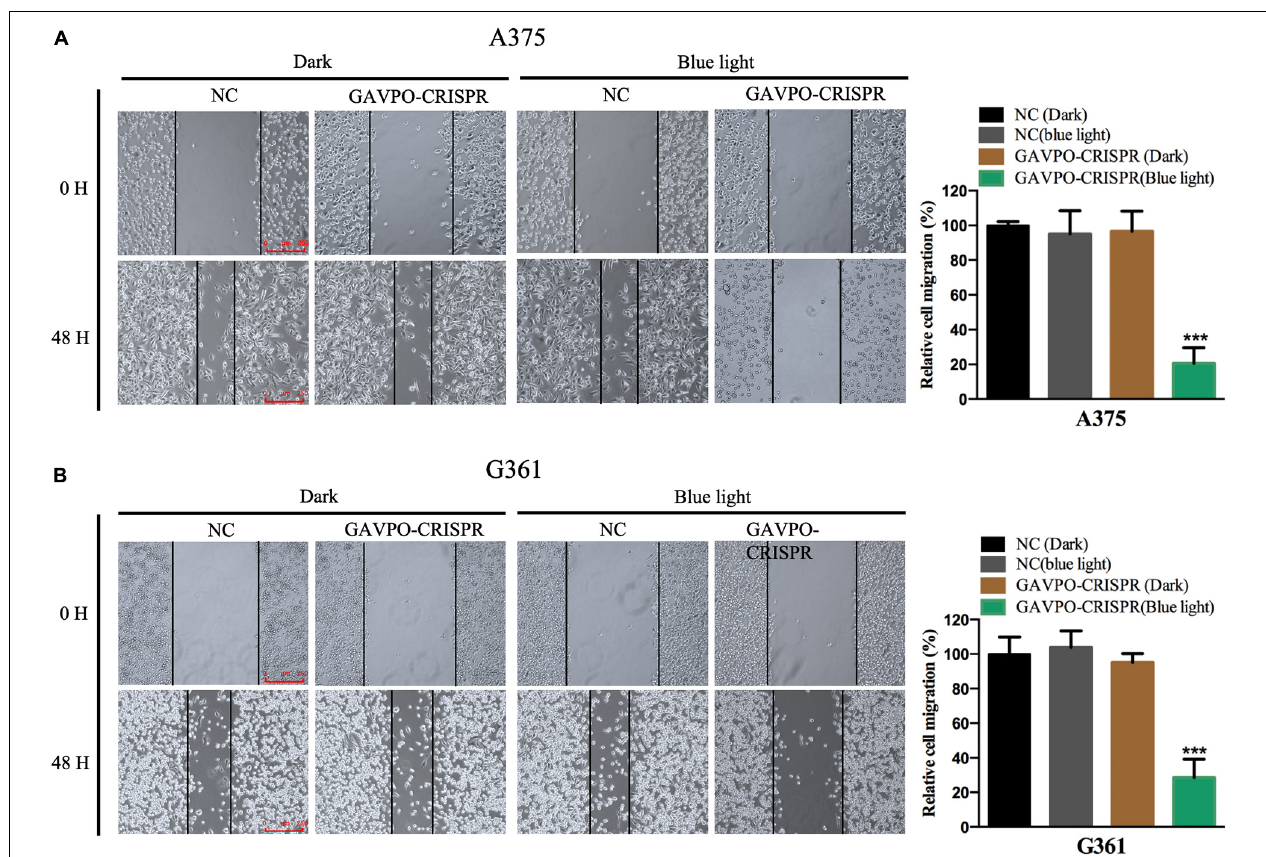
FIGURE 4 | Light-induced GAVPO-CRISPR system inhibited melanoma cell migration. (A) Wound healing assay implicating the effect of light-induced GAVPO-CRISPR system under blue-light or dark conditions on cell migration in A375 cells, compared to the negative control. (B) Wound healing assay representing the effect of light-induced GAVPO-CRISPR system under blue-light or dark conditions on cell migration in G361 cells, compared to the negative control. Data are presented as the means ± SD from at least three biological replicates. (* P < 0.05, ** P < 0.01, *** P <